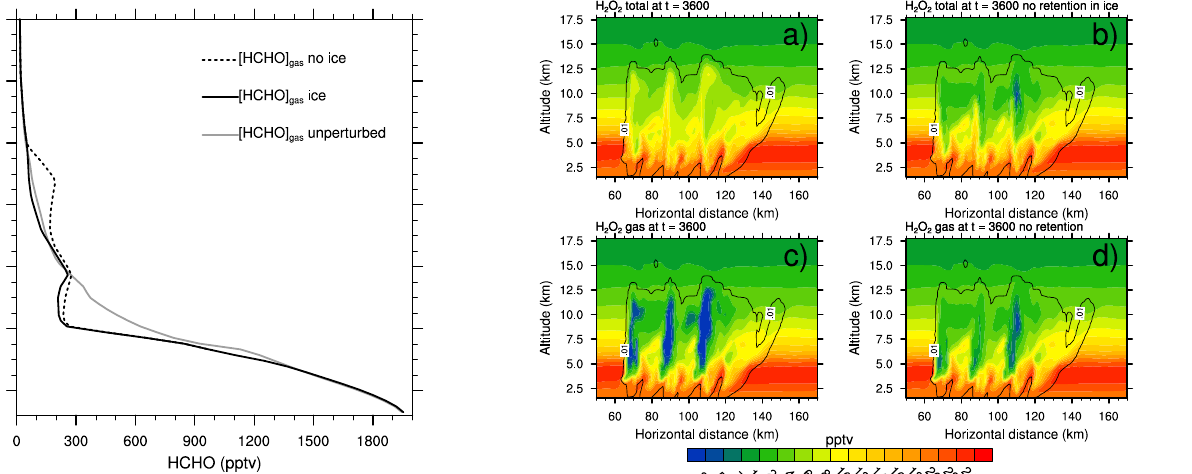
Figure 14. STERAO case: results at t = 3600 s for vertical cross section of H 2 O 2 mixing ratio 2 Fig. 14. STERAO case – results at t = 3600s for vertical cross sec- tion of H 2 O 2 mixing ratio inpptv along the segment indicated in in pptv along the segment indicated on Fig. 10a, on the left hand side for simulation with 3 Fig. 10a, left hand side, for simulation with retention in ice, and retention in ice and on the right hand side for the simulation without retention: (a) and (b) 4 right hand side for the simulation without retention: (a) and (b) total total mixing ratio, (c) and (d) in gas phase. The black line represents the total hydrometeors 5 mixing ratio, and (c) and (d) in gas phase. The black line represents mixing ratio equal to 0.01 g/kg. 6 the total hydrometeors mixing ratio equal to 0.01gkg − 1